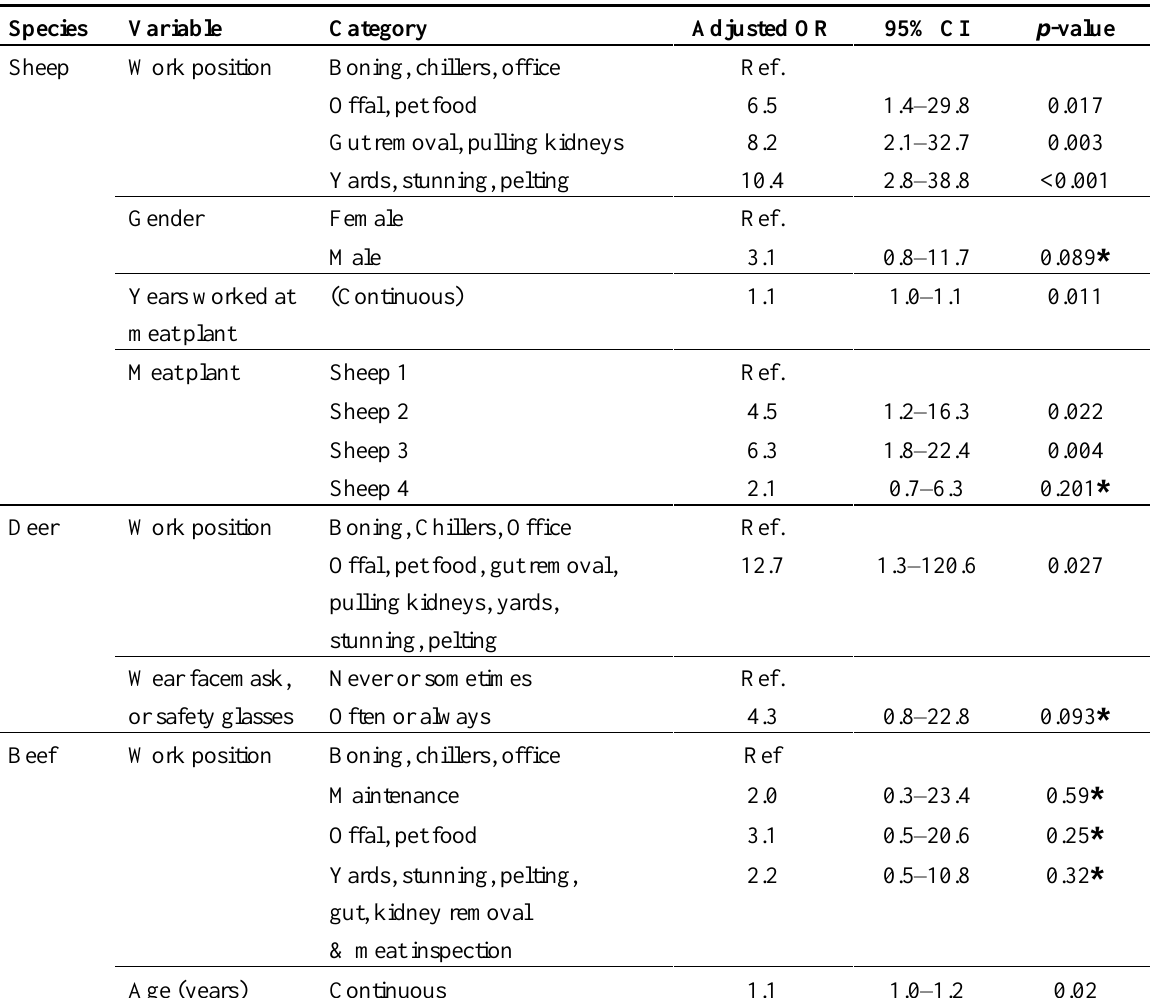
Table 1. Joint multivariable analysis of data from all plants: significant effects * on sero-prevalence of Leptospira interrogans sv . Pomona and/or Leptospira borgpetersenii sv . Hardjobovis in abattoir workers processing sheep (n = 325), deer (n = 56) and beef (n = 185) (November 2009–April